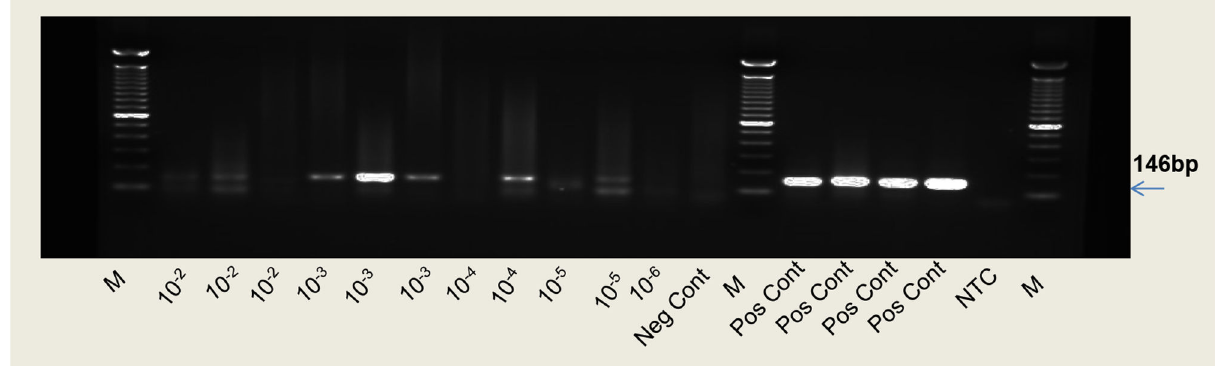
Figure 6. Sensitivity of MUP-uPA/SCID/Bg mice inoculated with HCV plasma derived from infected chimpanzee. Infection was determined by nested PCR on HCV RNA extracted from mouse sera. A 146bp nPCR product was detected by agarose gel electrophoresis. The lanes represent sera from mice inoculated serial 10-fold dilutions of an HCV infected chimpanzee serum that contained 10 4.5 CID50/mL.